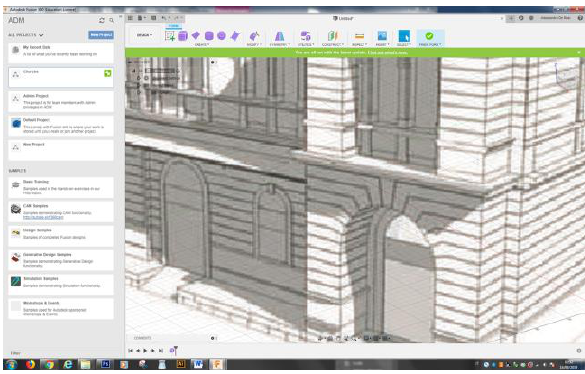
Figure 14 – Cloud Computing Platforms: Autodesk Fusion 360.